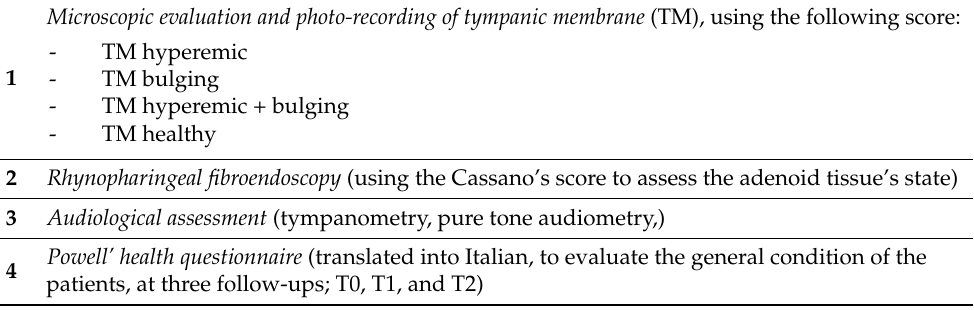
Table 1. Summary of investigations performed during the study.